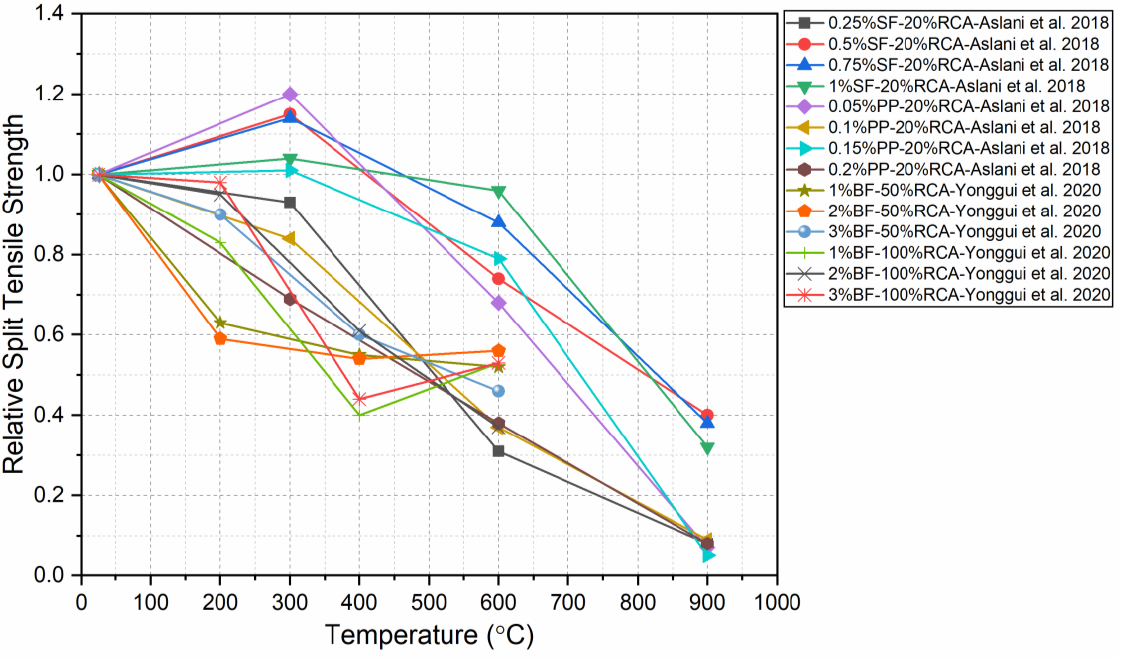
Figure 23. Effect of elevated temperatures and fiber dosages on relative residual splitting tensile strength of FRAC [37,51].